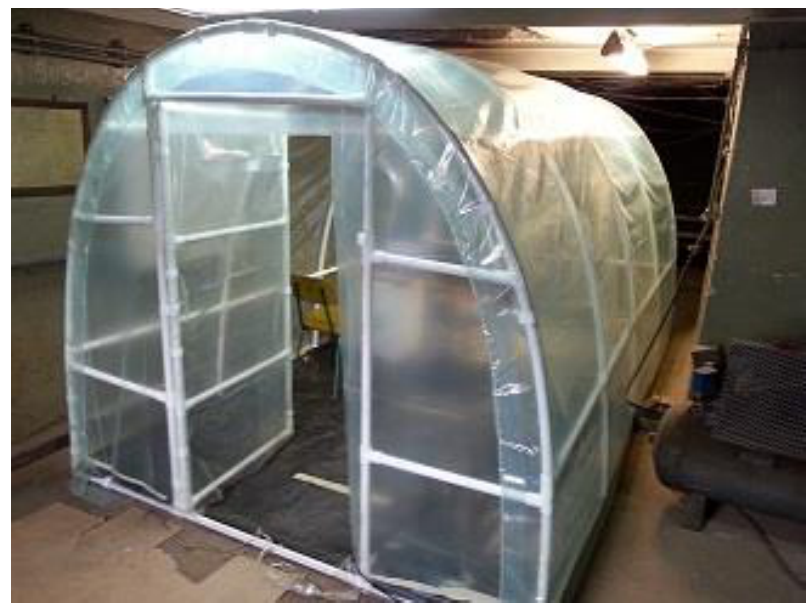
Figure 11. Photo of the tunnel enabling the simulation of various environmental conditions (temperature, and in the further part of the research — humidity).